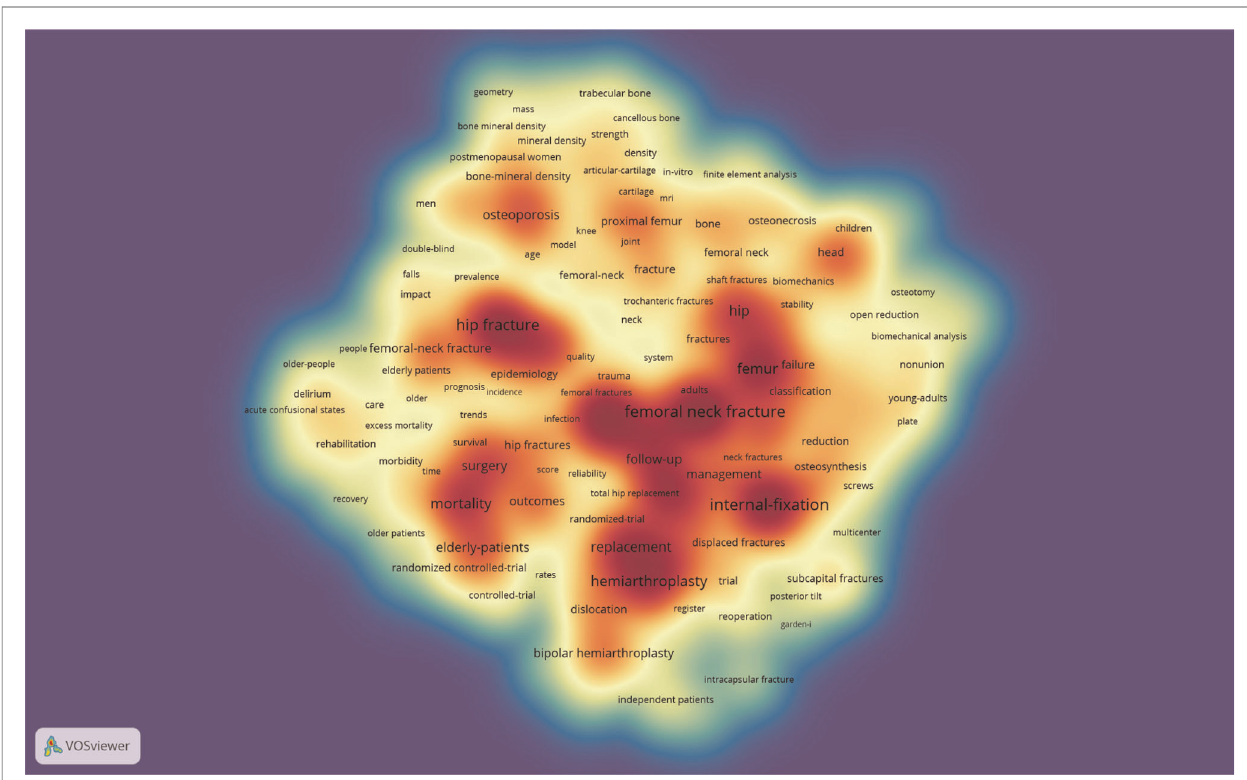
FIGURE 6 | The density visualization map of keyword co-occurrence analysis (generated by VOSviewer). The darker the color, the higher the keyword